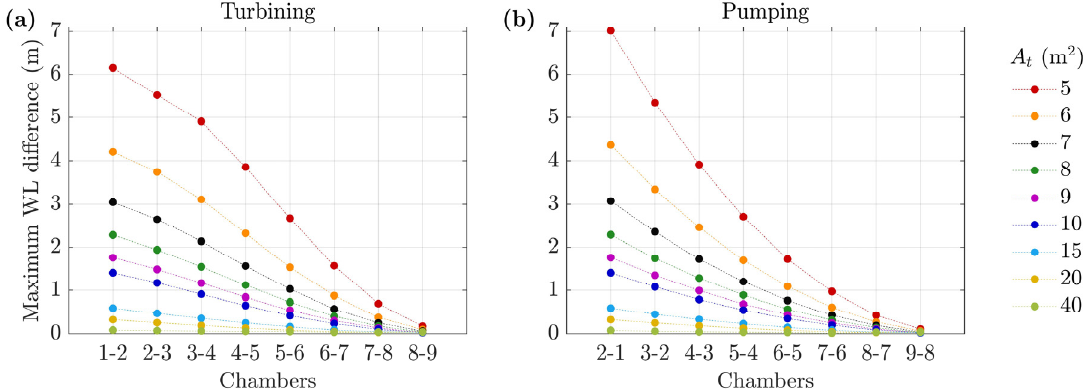
Figure 7. Maximum di ff erences of water level (WL) in successive chambers of the underground